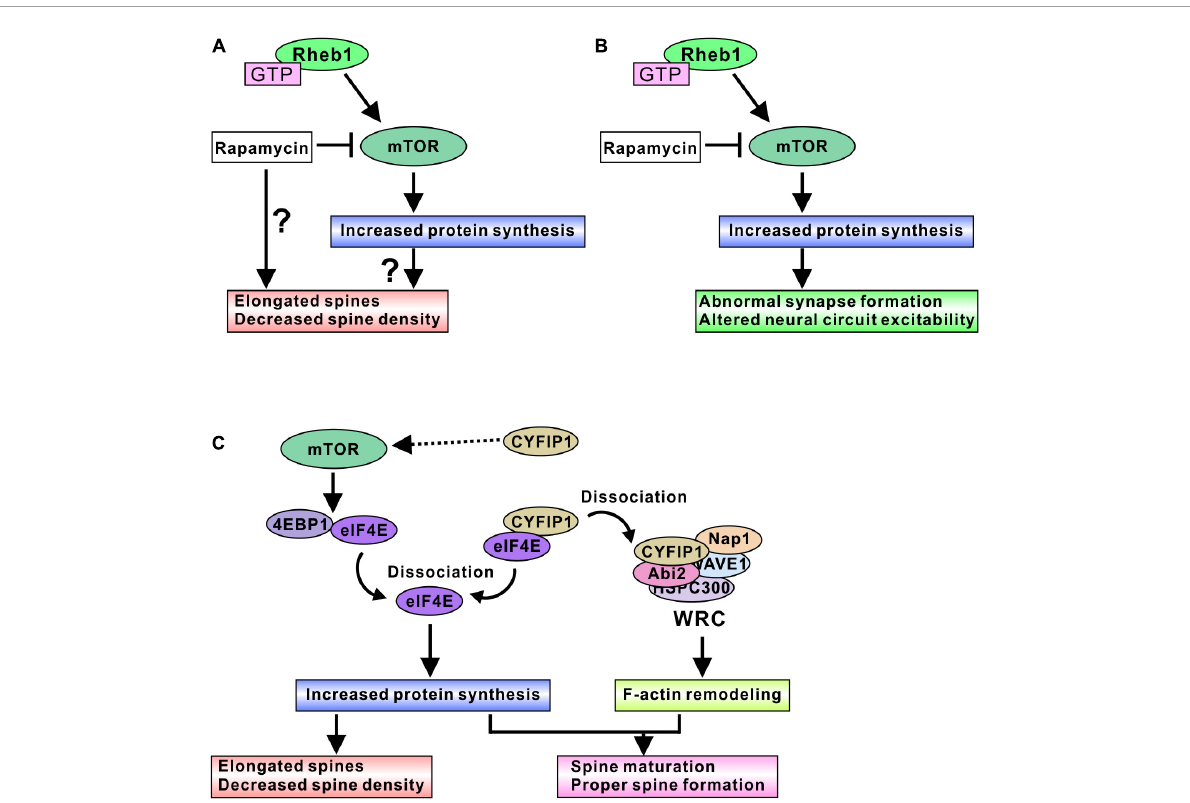
FIGURE2 mTORC1-mediated spine and synapse regulation in TSC models. (A) Active mTORC1 may elongate dendritic spines and decrease spine density, probably through the increased protein synthesis. In addition, rapamycin treatment could aggravate the spine dysmorphogenesis. (B) Active mTORC1 alters synapse function and neural circuit excitability. Inhibition of mTORC1 by rapamycin and its derivative normalizes abnormal neural excitability, indicating mTORC1-mediated protein synthesis is involved in adequate synapse formation and function. (C) Schematic model of protein synthesis and spine morphogenesis. Active mTORC1 dissociates eIF4E from 4EBP1, and dissociated eIF4E promotes protein synthesis. Dysregulation of protein synthesis may cause elongated spine formation. However, rapamycin experiments suggest that modulation of protein synthesis alone does not provide the correct control of spine morphogenesis. CYFIP1 is another binding partner of eIF4E. Dissociation of eIF4E from CYFIP1 also promotes protein synthesis. Furthermore, dissociated CYFIP1 is incorporated into WRC protein complex and regulates F-actin remodeling, suggesting that CYFIP1-mediated protein synthesis control is associated with the F-actin remodeling changes. Therefore, regulation of both protein synthesis and F-actin remodeling could be required for the normal spine formation and maturation. Because excess amount of CYFIP1 activate mTORC1 signaling, CYFIP1 may be another regulator of mTORC1